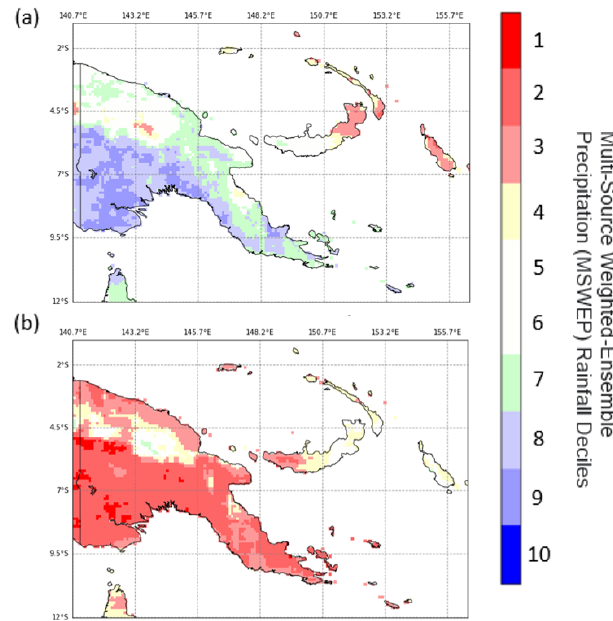
Figure 1. Multi-Source Weighted-Ensemble Precipitation (MSWEP) rainfall deciles in (a) La Niña events (La Niña years being 1988, 1989, 1995, 1998, 1999, 2000, 2007, 2010, 2011 and 2020) and (b) El Niño events (El Niño years being 1982, 1987, 1991, 1992, 1994, 1997, 2002, 2006, and 2015) compared to a base period of 1980–2020. Figure adapted from Bhardwaj et al.